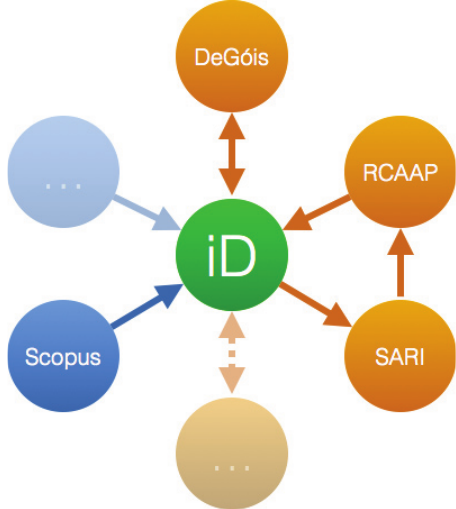
Figure 1. PTCRIS synchronization